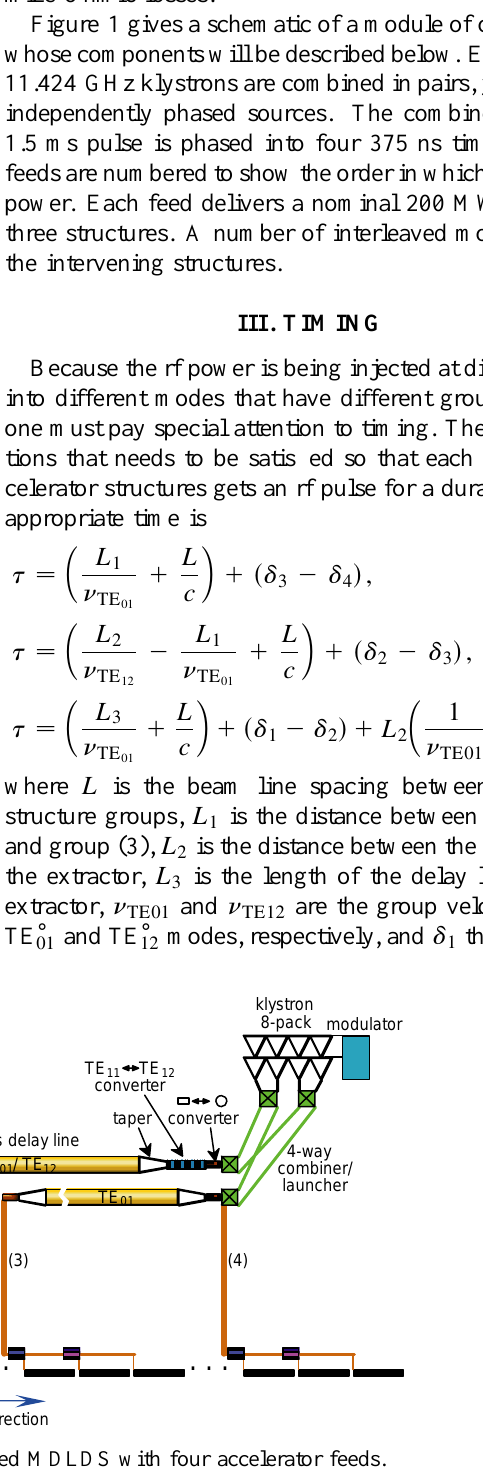
FIG. 1. (Color) Schematic of the dual-moded MDLDS with four accelerator feeds.